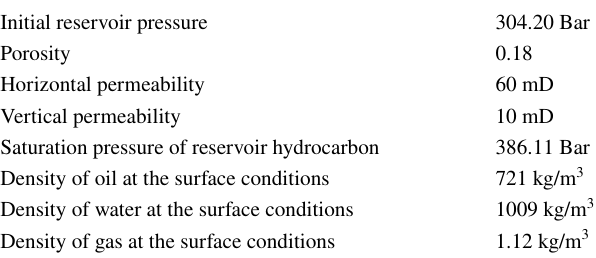
Table 1 Characteristics of the reference oil reservoir